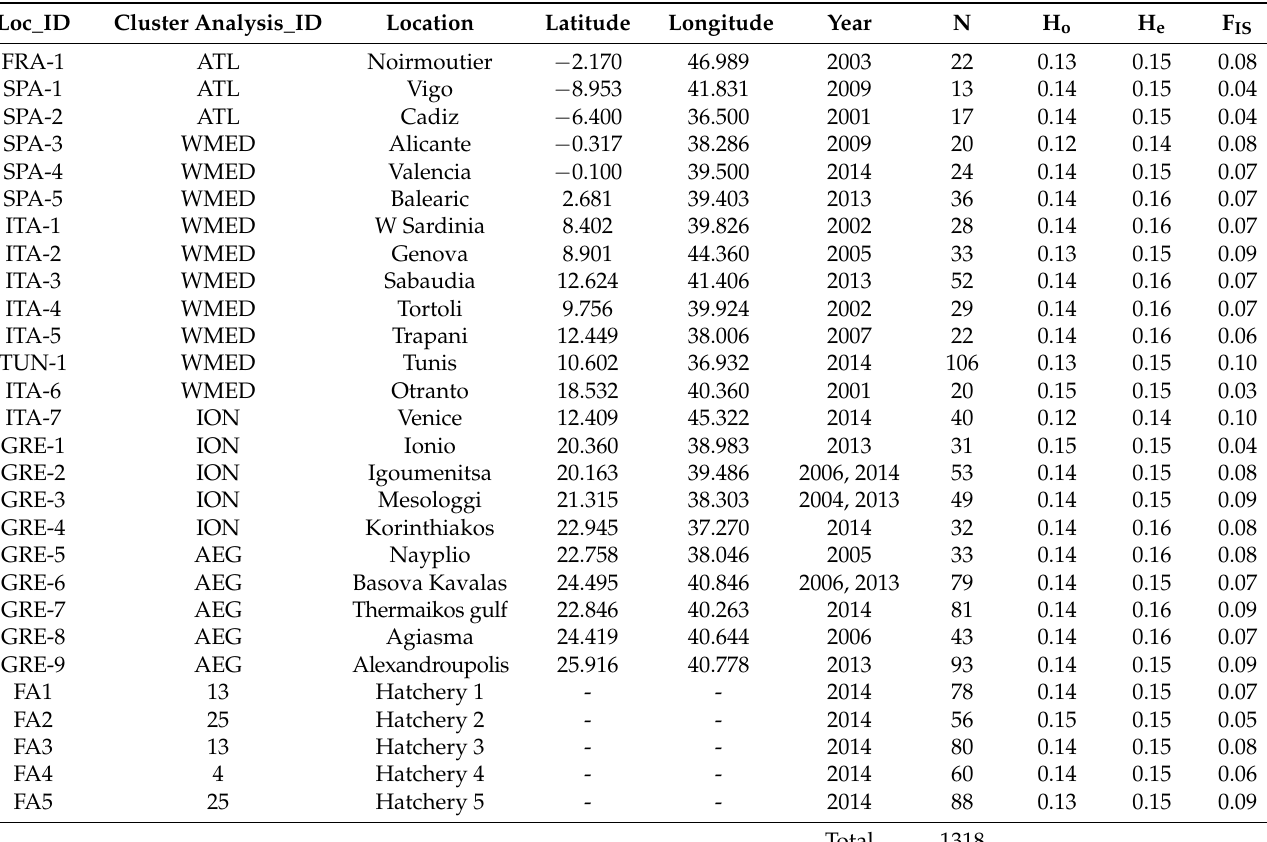
Table 1. Sampling site information and basic